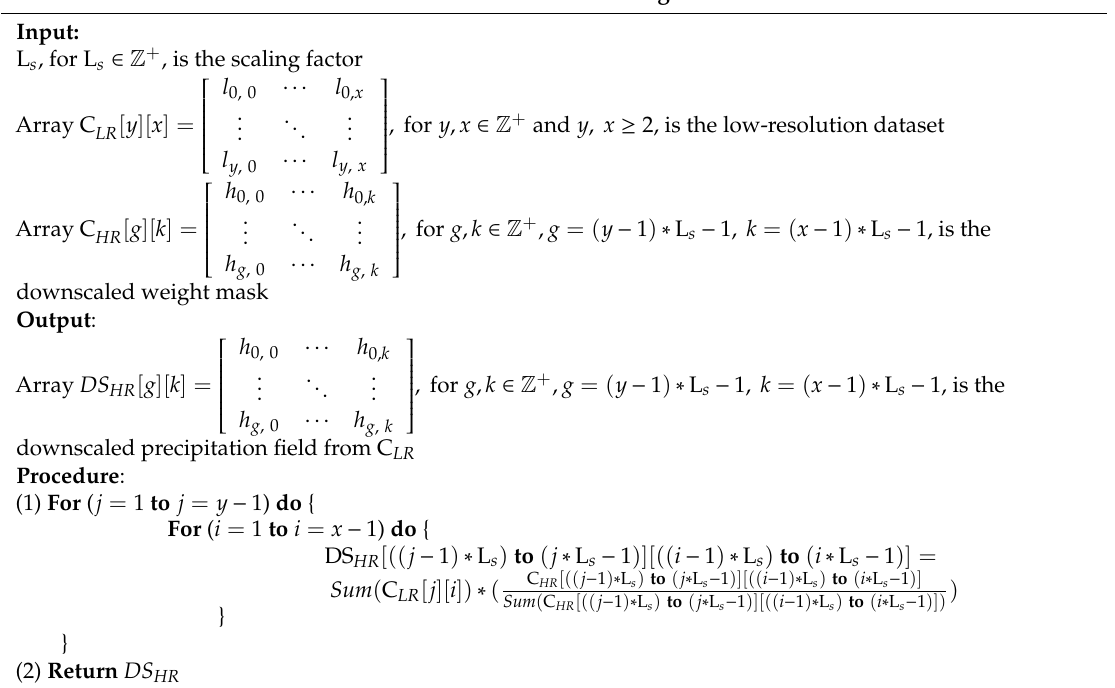
Table 5. Downscaling algorithm based on a weighted mask and